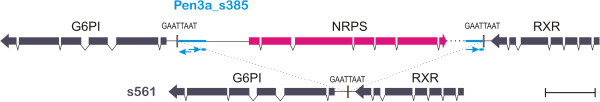
Penelope-mediated mobilization of an intron-containing NRPS gene. Shown are the two scaffolds which constitute an allelic pair containing glucose-6-phosphate isomerase (G6PI) and RXR-like retinoic acid receptor (RXR) coding sequences. Scaffold 385 harbors a NRPS insertion flanked by Pen3a pLTRs (see Figure 2i) and by an 8-bp target site duplication (GAATTAAT), which is present only once on scaffold 561. Introns are denoted by V-shaped lines; other features are as in Figure 2. Scale bar, 1 kb.